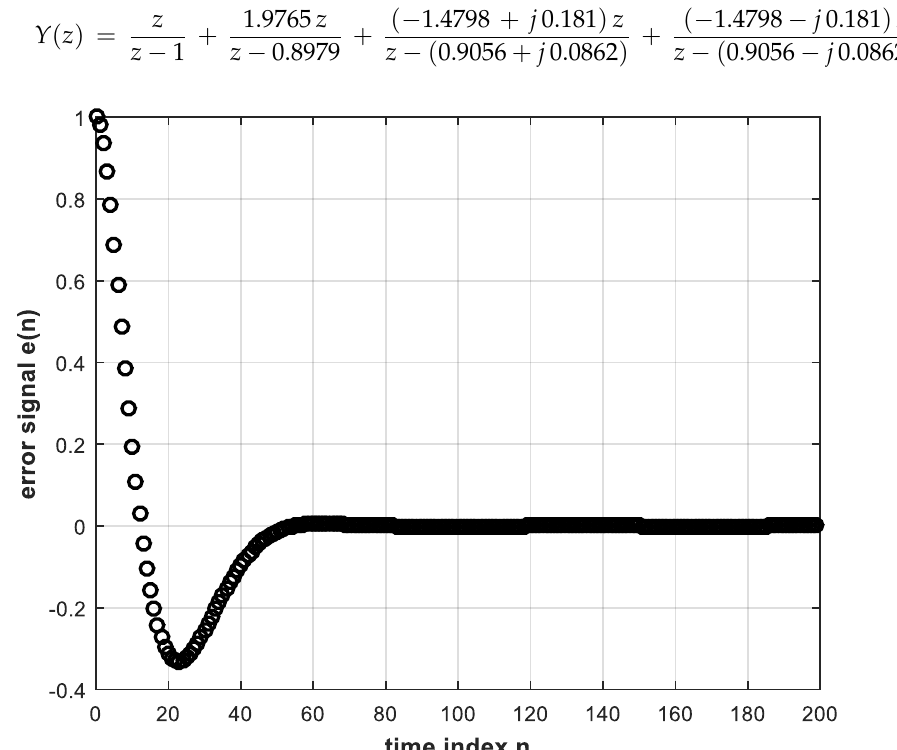
Figure 3. The error signal input to the digital controller.